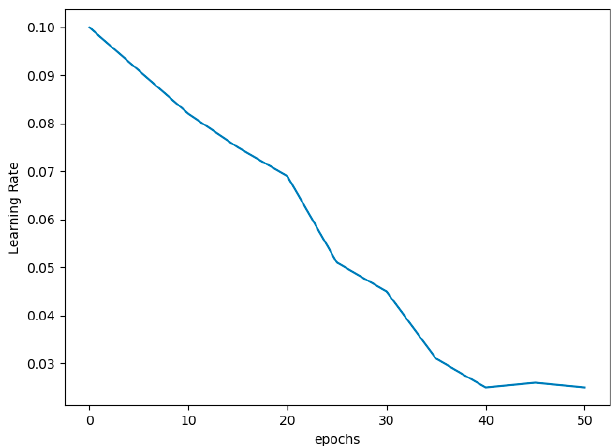
Atmosphere 2019 , 10 , x FOR PEER REVIEW Figure 5. Gradual decrease in Learning rate for Intensified LSTM. Figure 5. Gradual decrease in Learning rate for Intensified LSTM.